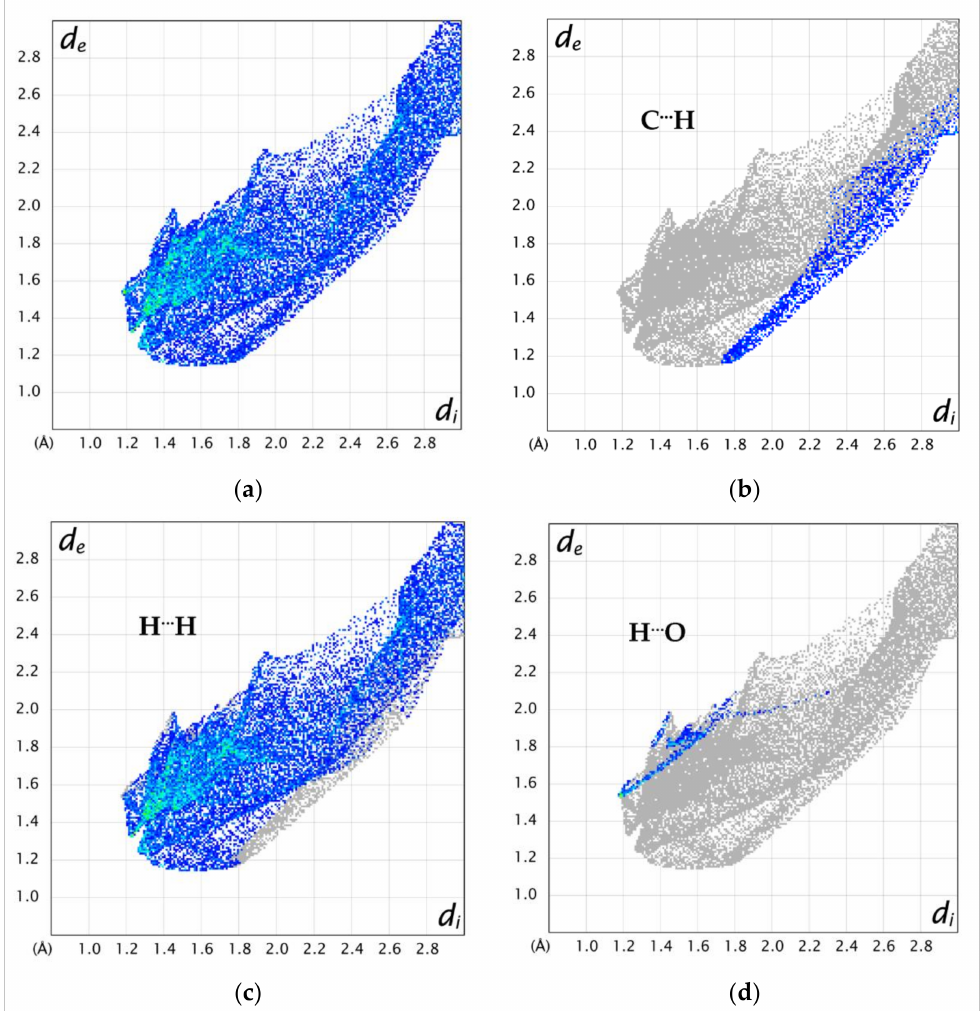
Figure 8. Two-dimensional fingerprint plot for toluene molecule in ε · tol-phase showing contributions of individual types of interactions: ( a ) all interactions plot, ( b ) C ··· H, ( c ) H ··· H, and ( d ) H ··· O interactions